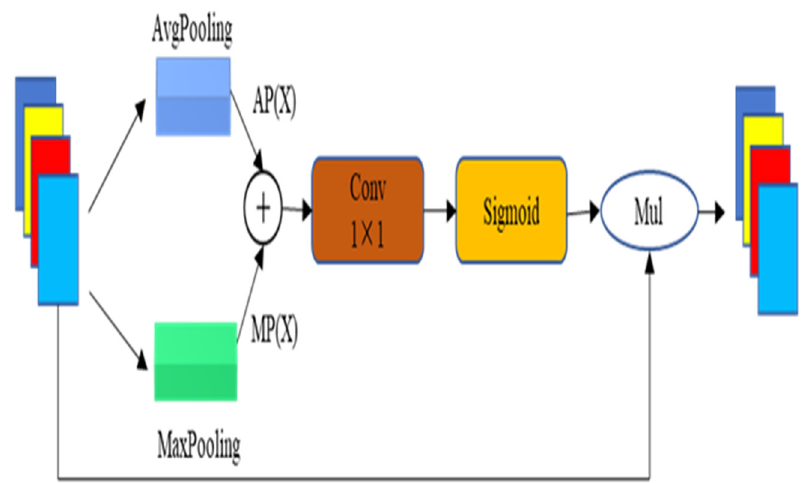
Figure 4. Attention structure.